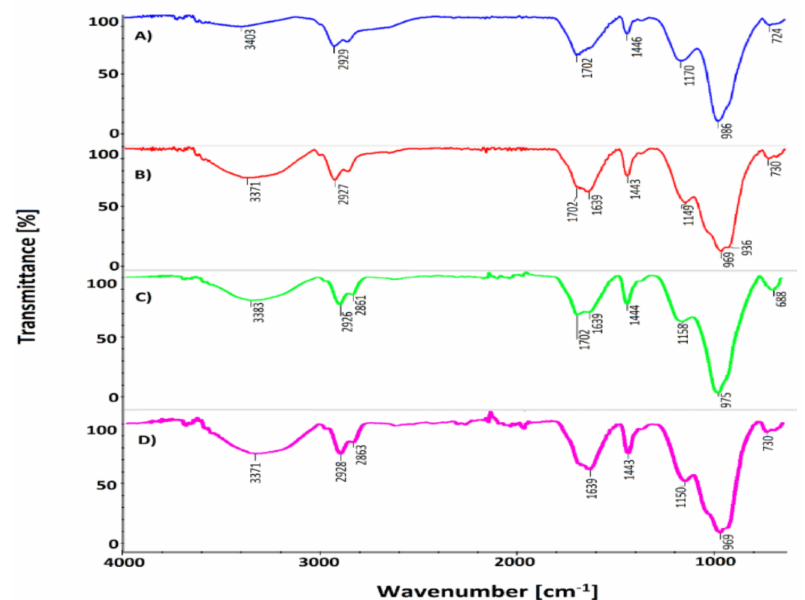
Figure 1. Normalized transmittance FTIR spectra of: A ) PhCP, B ) Ni-PhCP, C ) Fe-PhCP, and D )